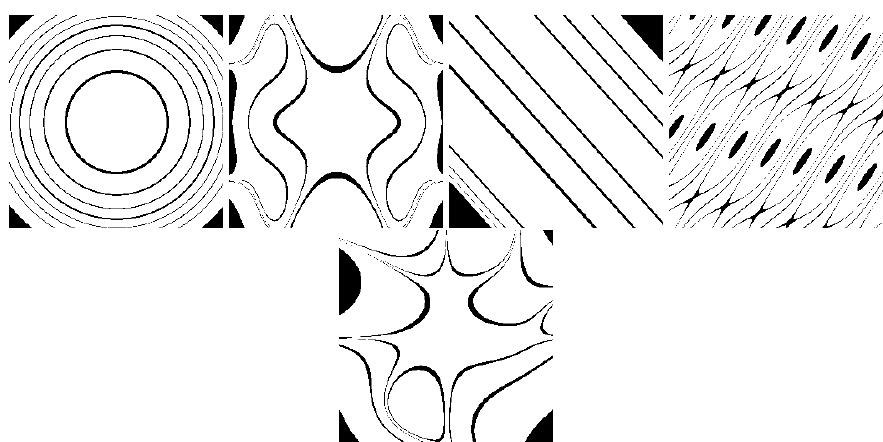
Figure 2: From left to right and top to bottom: Examples of potentials with symme- tries ( O ( 2 ) , Z , T , T , (cid:59) n 2